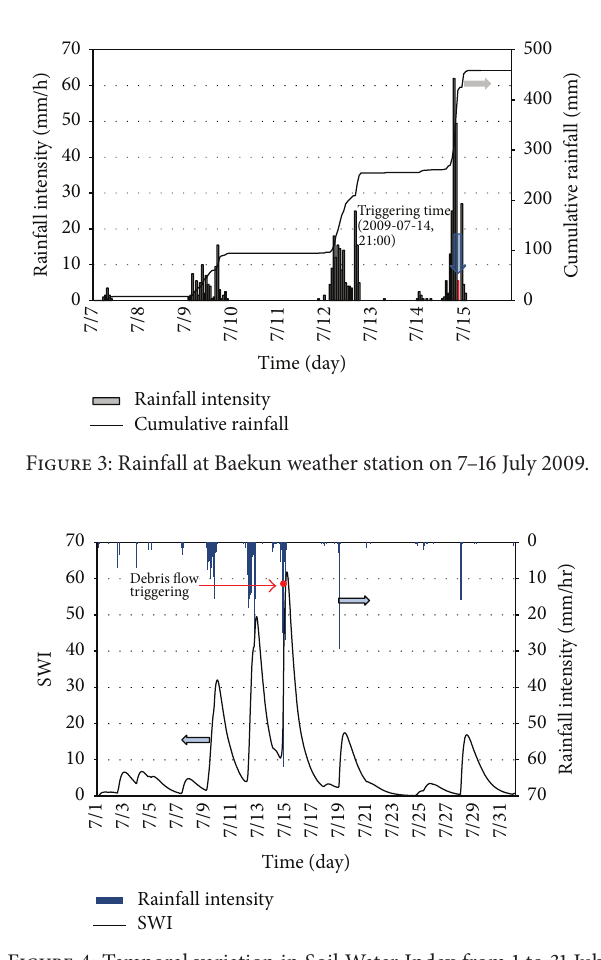
Figure 4: Temporal variation in Soil Water Index from 1 to 31 July 2009 in Jecheon area.